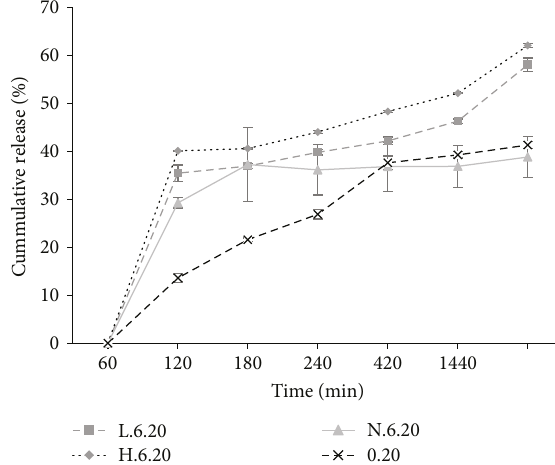
Figure 8: Drug release of acetaminophen from oxidized pectin-gelatin hydrogels. The cumulative amount of acetaminophen released is presented as function of time. The samples used for this analysis were H.6.20 (6% HOP and 20% of gelatin), L.6.20 (6% LOP and 20% of gelatin), N.6.20 (6% NOP and 20% of gelatin), and 0.20 solely gelatin (20%